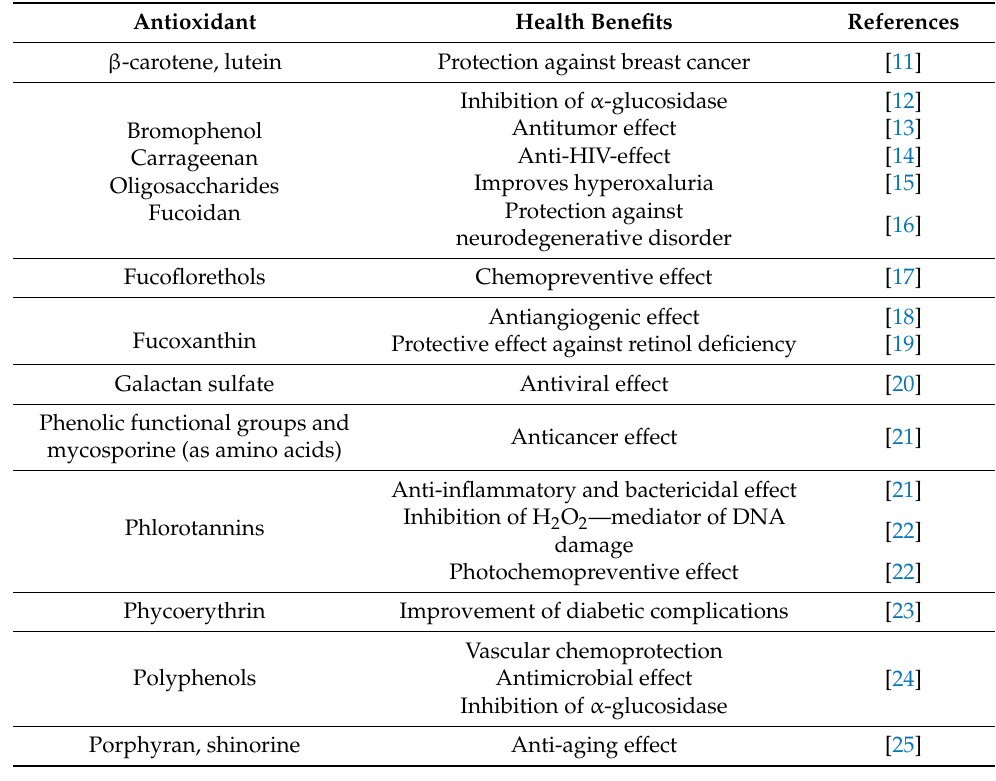
Table 1. Antioxidant components and health benefits for compounds, derived from marine algae.